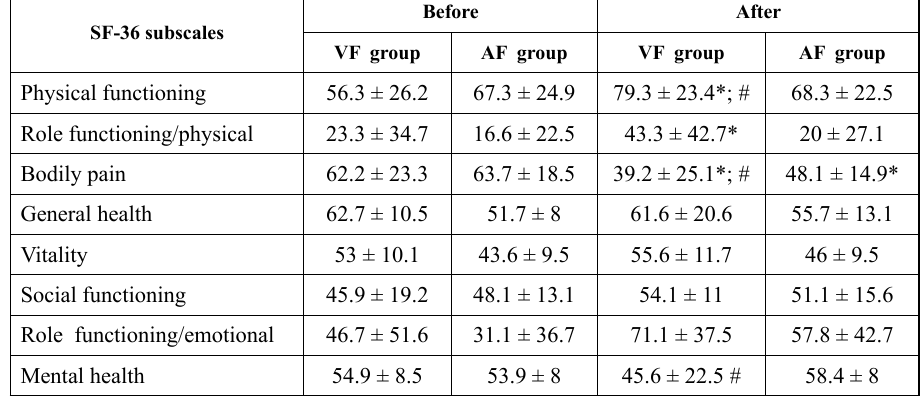
Note. *p < .05, statistically significant difference be - tween pre-experimental and post-experimental results. All figures in table are av - erages of all group subject results.